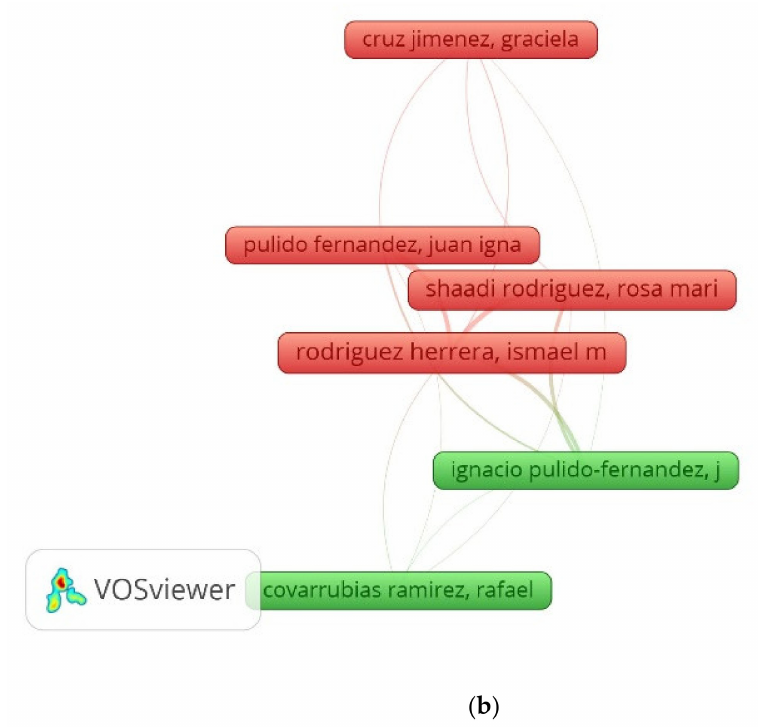
Figure 10. Bibliographic coupling analysis for authors, ( a ) Scopus, ( b ) WoS. Source: Own elaboration.